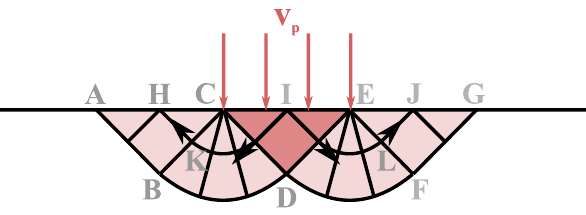
Figure 1. Prandtl’s analytical solution of a rigid die indenting a rigid-plastic half space (Davis and Selvadurai, 2002; Kachanov, 2004; Thieulot et al., 2008). Dark red arrows indicate the prescribed punch velocity v p . The shaded area inside CDE has a resulting ve- locity of v CDE = v p , while velocities in the lightest shaded areas are v p √ v ABDC = v EDFG = . Pressure at point I is P I = σ y ( 1 + π) and 2 P ABC = P EFG = σ y